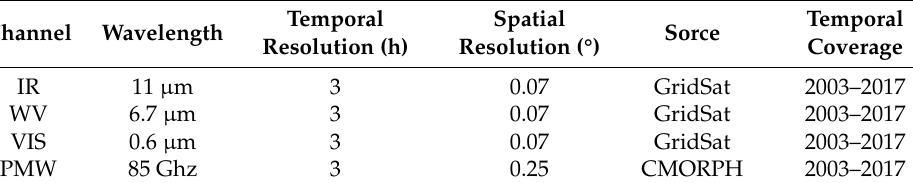
Table 1. Detailed description of the four channels of the benchmark dataset.